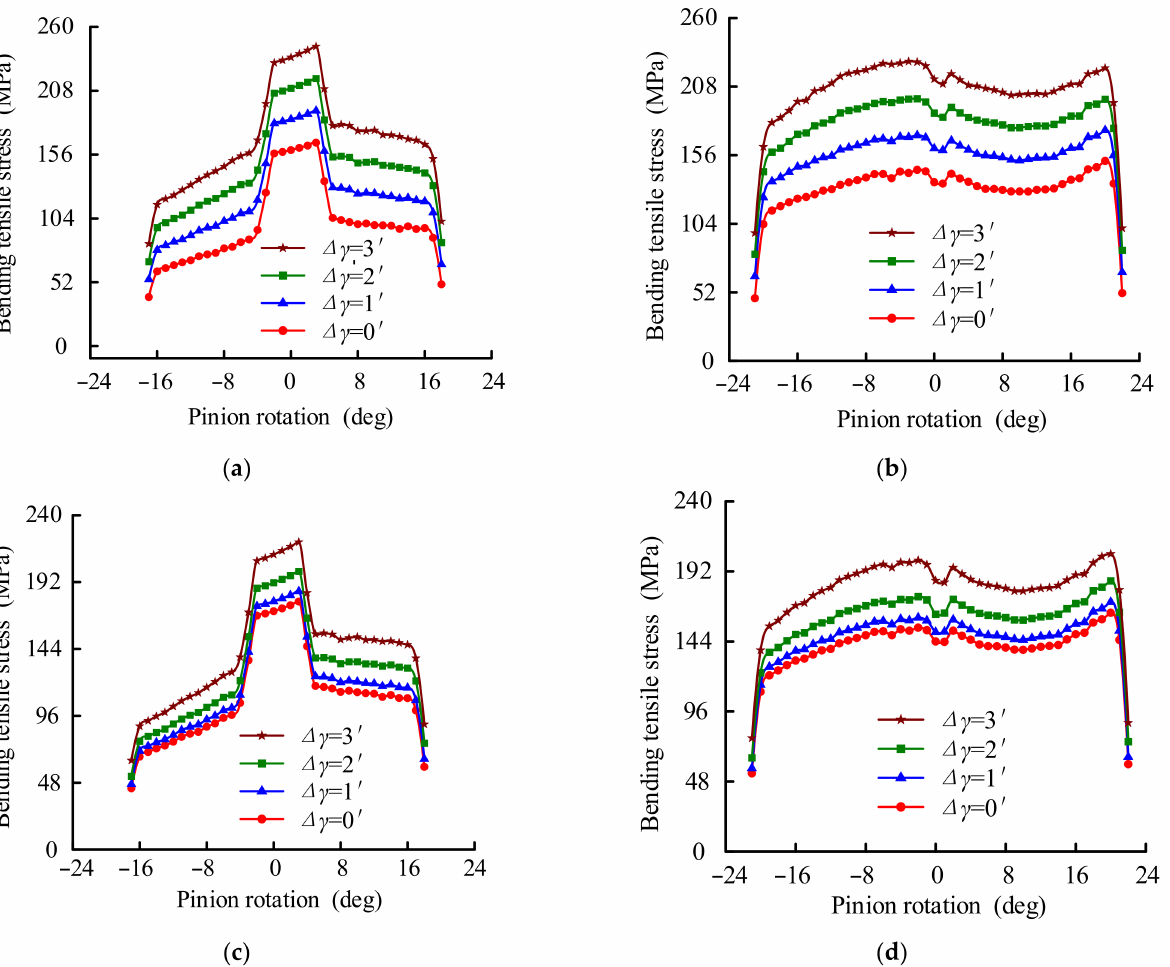
Figure 21. Comparison of bending tensile stress between novel gears and involute gears with different misalignment errors. ( a ) Unmodified involute gears; ( b ) Unmodified novel gears; ( c ) Modified involute gears; ( d ) Modified novel